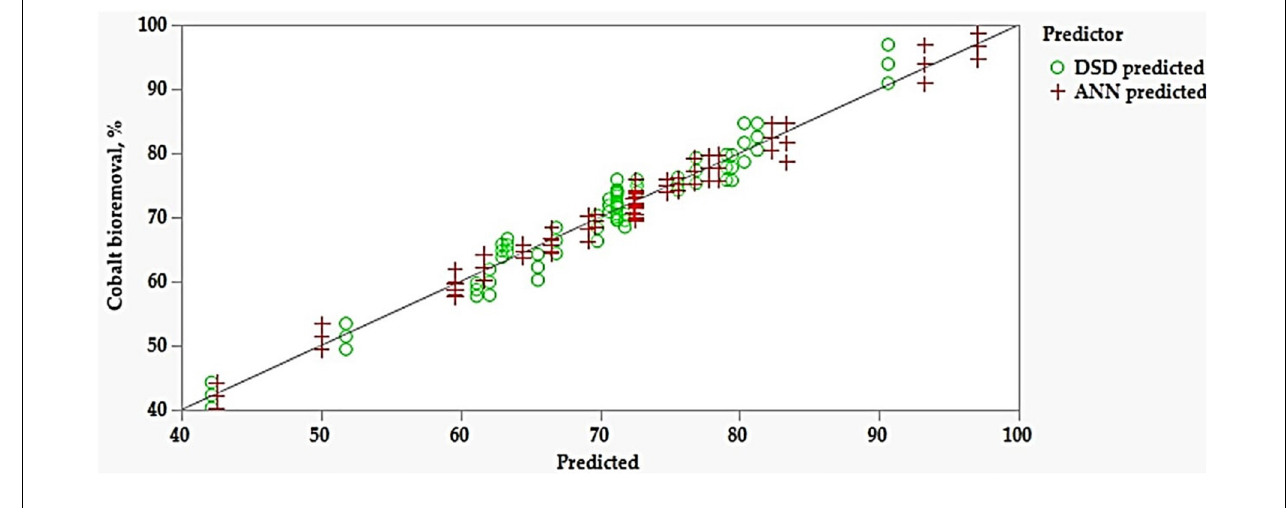
FIGURE 4 | Actual by the predicted plot for cobalt bioremoval by P. alcaliphila .